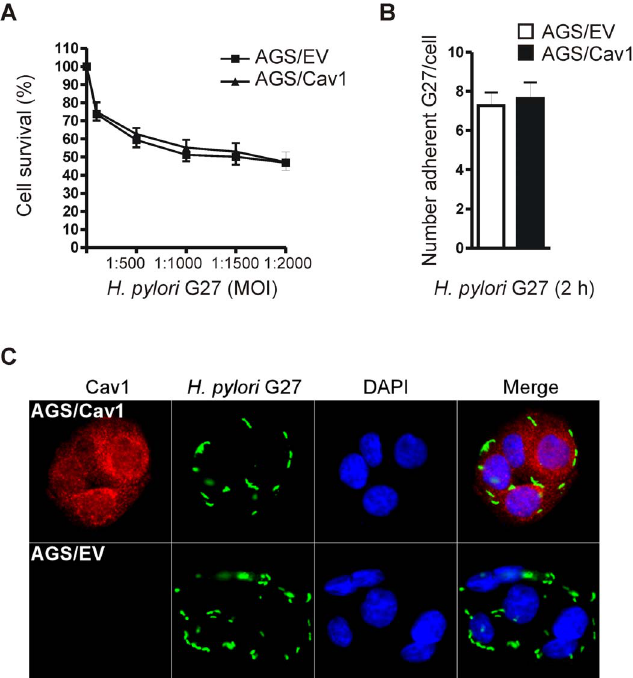
Figure 3. Cav1 has no effect on adhesion of H.pylori to or on viability of human GC cells. (A) Proliferation. AGS/Cav1 and AGS/EV cells (‘‘AGS clones’’) were infected with the cell-adapted CagA-delivery proficient H. pylori strain G27 strain for 48 h at MOI ratios of 1:100 to 1:2000. O.D. values from colorimetric MTT assays were calculated as % survival 6 S.E. (n=3); n.s. Cav1 versus EV. (B–C) Adhesion. AGS clones were infected with G27 (MOI=10) for 30 min, washed, and additionally incubated in fresh medium for 2 h before staining for immunofluorescence microscopy; green= H. pylori , red=Cav1, blue=nuclei. Magnification 6 630. Representative images (C) are shown together with a quantitative analysis (B). Adherent bacteria per Cav1-positive and Cav1-negative cells were counted ( . 10 cells per field, total of 5 fields, n=3 experiments) and presented as mean 6 S.E.; n.s. Cav1 versus EV.